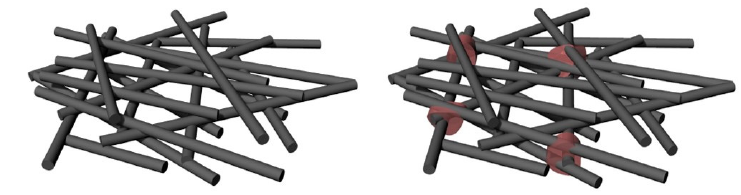
Figure 4. The schematic diagram of the CF felt and CF/C felt.